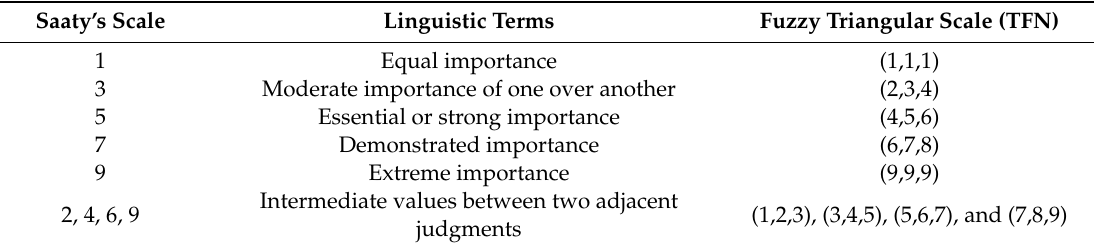
Figure 4. The hierarchy structure for the performance evaluation process of groundwater quality assessment. Table 1. Linguistic terms and the corresponding triangular fuzzy